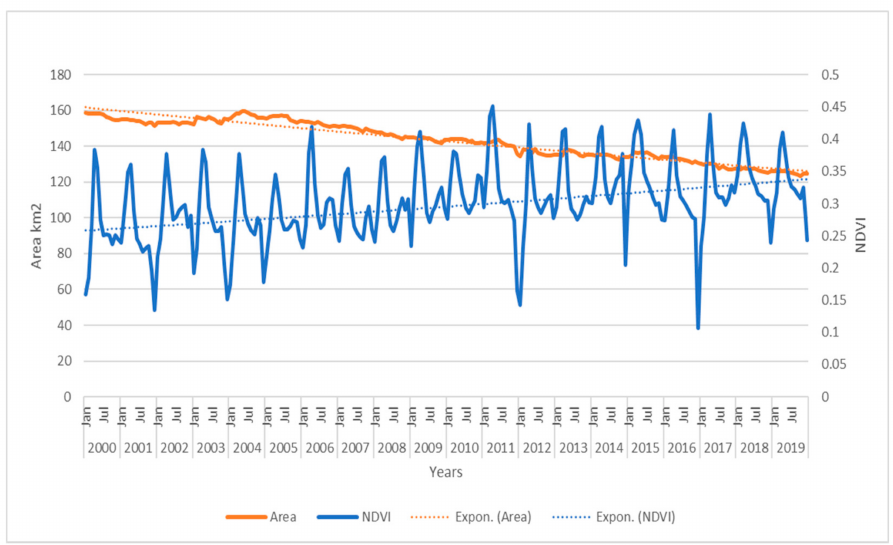
Figure 9. The relationship between the reduction in the area of the lake and the NDVI